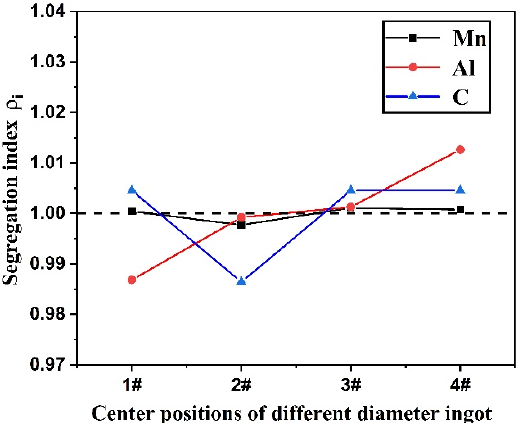
Figure 10. Variation of element segregation index at the center of the ingot with different diameters.